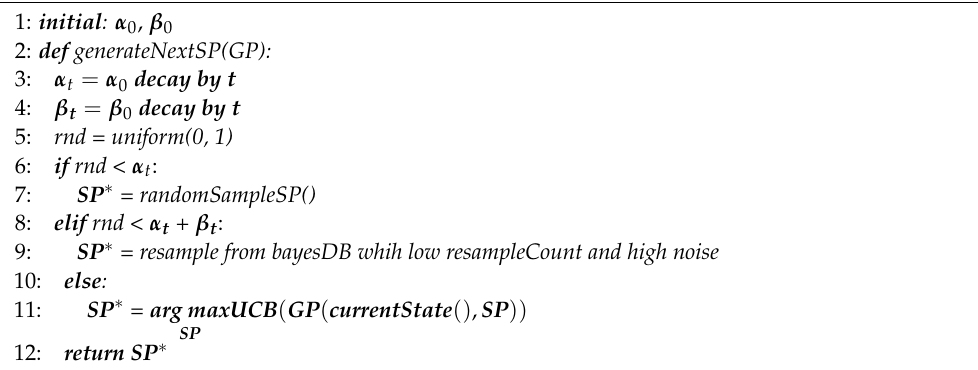
Algorithm 5: Pseudocode to generate the next setpoints, as the in-place replacement of the argmax line in Algorithm